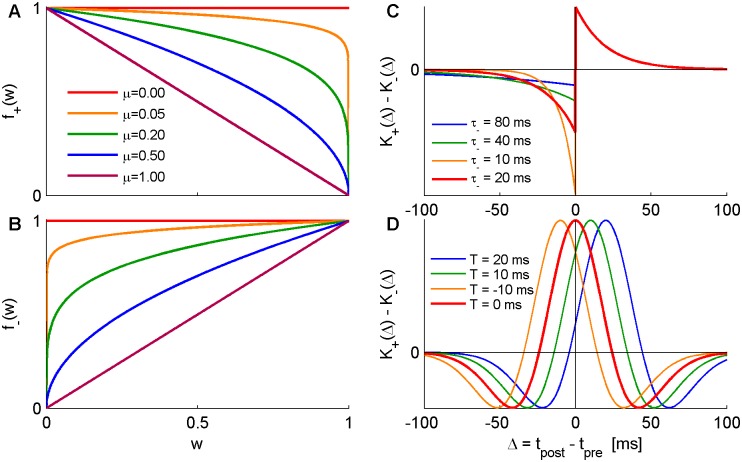
Illustrations of the STDP rules studied in this paper.(A,B) The weight dependence of the STDP rule, f+(w), eq (2) and f−(w), eq (3), with α = 1. Shown for different values of μ in different colors. (C) The “temporally asymmetric exponential” temporal kernel, eq (4), with H = 1 (for Hebbian rule), τ+ = 20ms. Different values of τ− are shown in different colors. (D) The “difference of Gaussians” temporal kernel, eq (5), with τ+ = 20ms, τ− = 30ms, different values of T+ = T−: = Tshown in different colors.